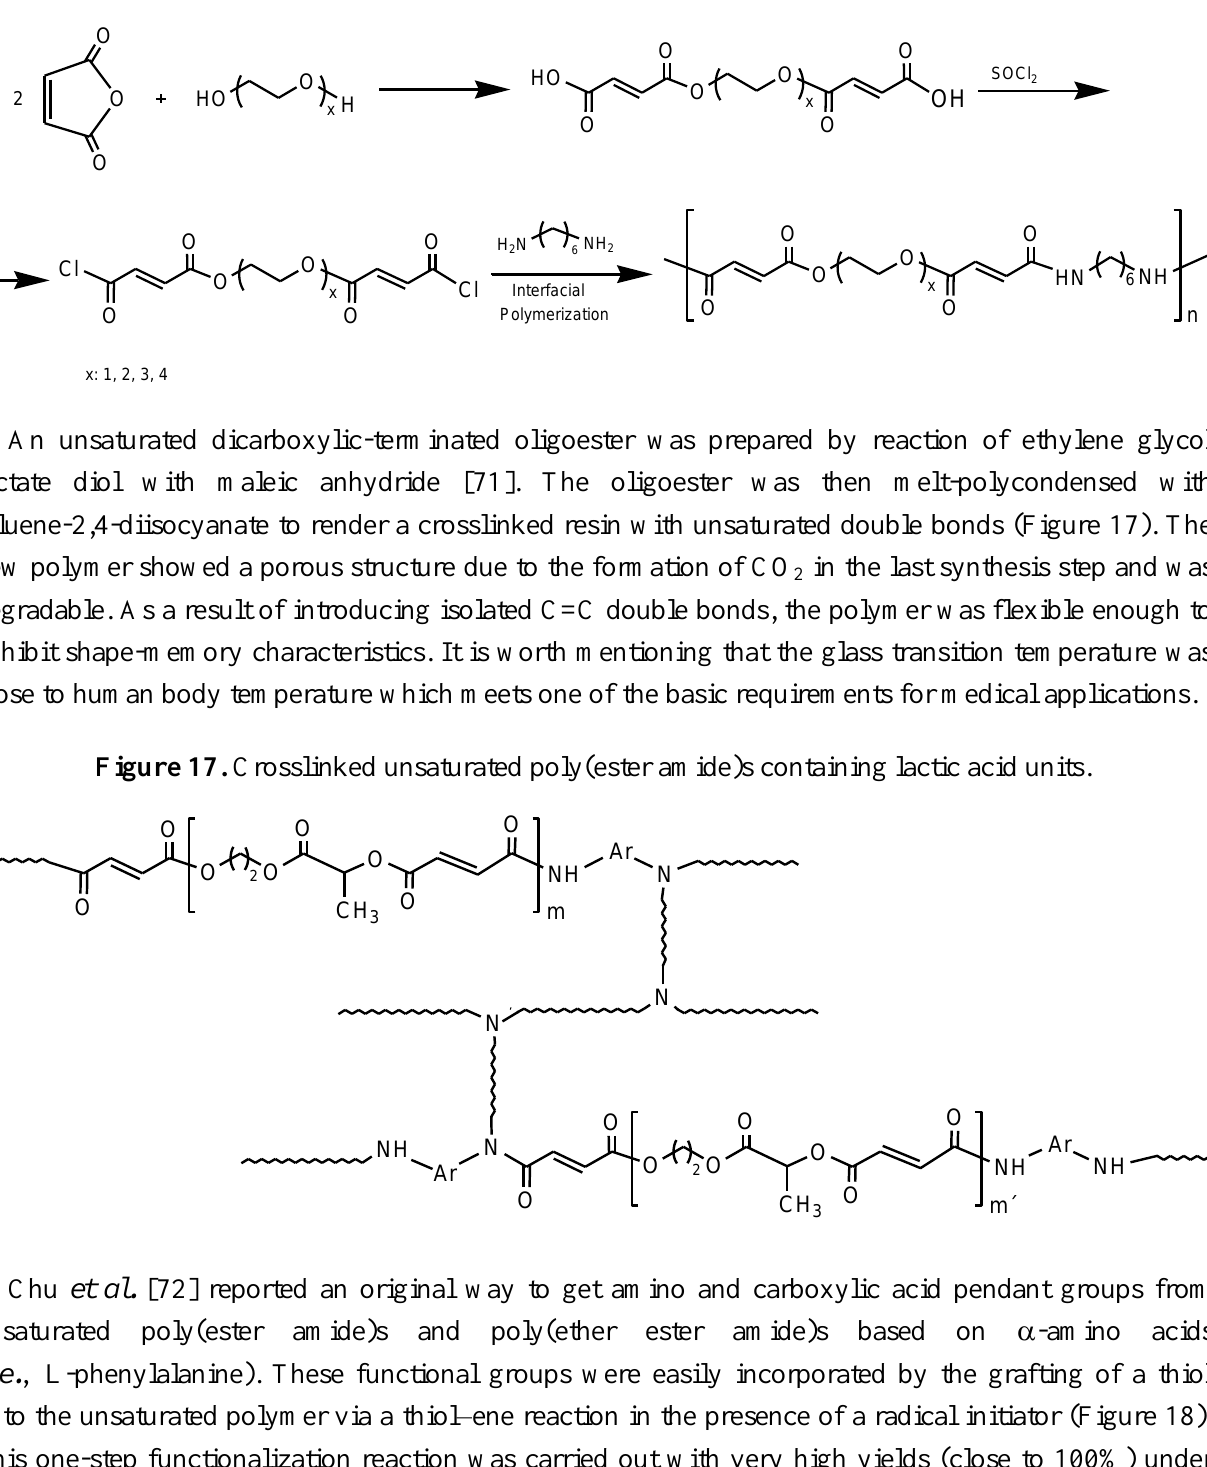
Figure 16. Synthesis of unsaturated poly(ether ester amide)s from maleic anhydride and oligo(ethylene